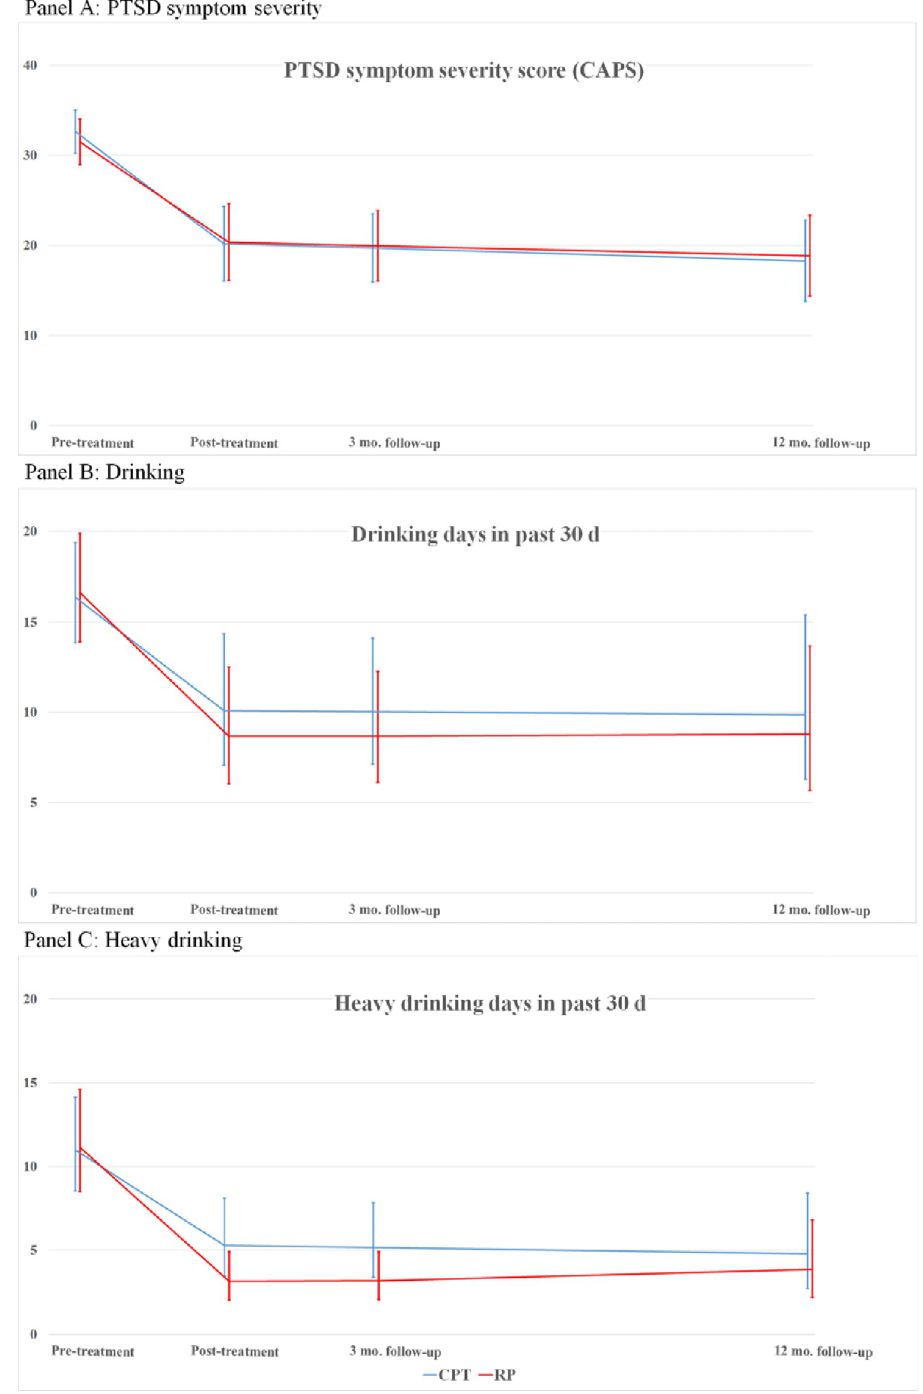
Fig 2. Model predicted means and 95% confidence intervals for PTSD symptom severity (Panel A), drinking days in the past 30 (Panel B), and heavy drinking days in the past 30 (Panel C) by treatment condition from pre-treatment to 12-month